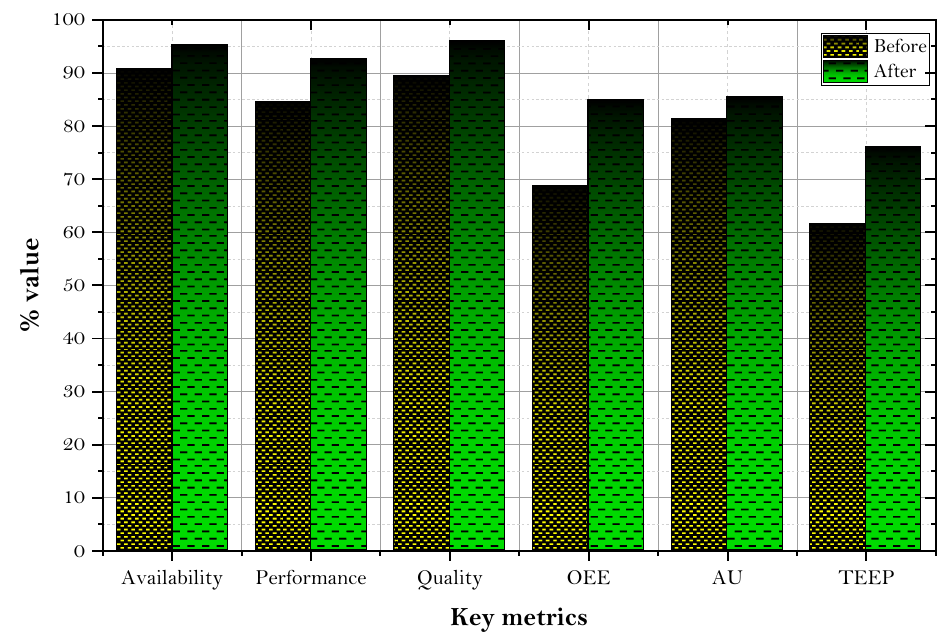
Figure 14. Comparison of key metrics.